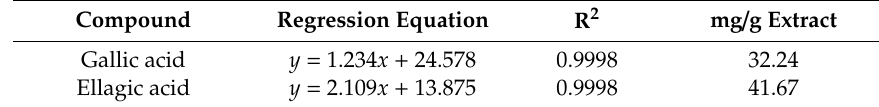
Table 1. Concentrations (mg/g) of the compounds present in the aqueous extract of Punica granatum L. Compound